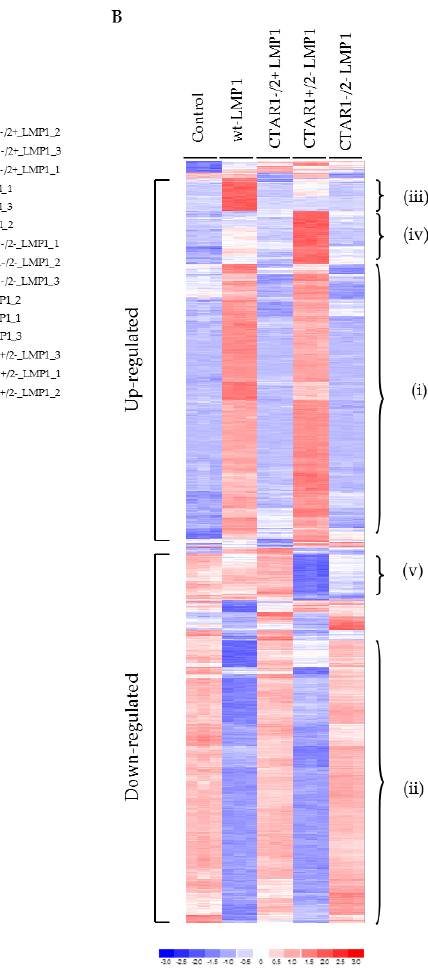
Figure 3. Heatmaps of Pearson correlation and relative expression of probe sets differentially expressed among the five groups identified by multiclass SAM analysis. ( A ) Heatmap of Pearson correlation (ranging from 0.948 to 1) of the 15 individual arrays utilised in this study. The relative expression of all probe sets was exploited in the calculation of Pearson correlation; ( B ) The top 1021 probe sets differentially expressed among the five groups were identified by multiclass significance analysis of microarrays (SAM) analysis with the criteria of fold change greater than 2% and 0% false discovery rate (FDR). Gene expression heatmaps were generated using dChip (http://www.dchip.org) with the default settings. The heatmap highlights differences in the induction of various genes, which is noted by the difference in the intensity of the bars: blue (low) or red (high). A high-level examination of the heatmap revealed genes whose expression could be clustered into those that were: (i) significantly upregulated in wildtype LMP1 and CTAR1+/2− LMP1-expressing cells; (ii) significantly downregulated in wildtype LMP1 and CTAR1+/2− LMP1-expressing cells; (iii) significantly upregulated in wildtype LMP1-expressing cells only; (iv) significantly upregulated in CTAR1+/2− LMP1-expressing cells only; (v) significantly downregulated in CTAR1+/2− LMP1-expressing cells only.